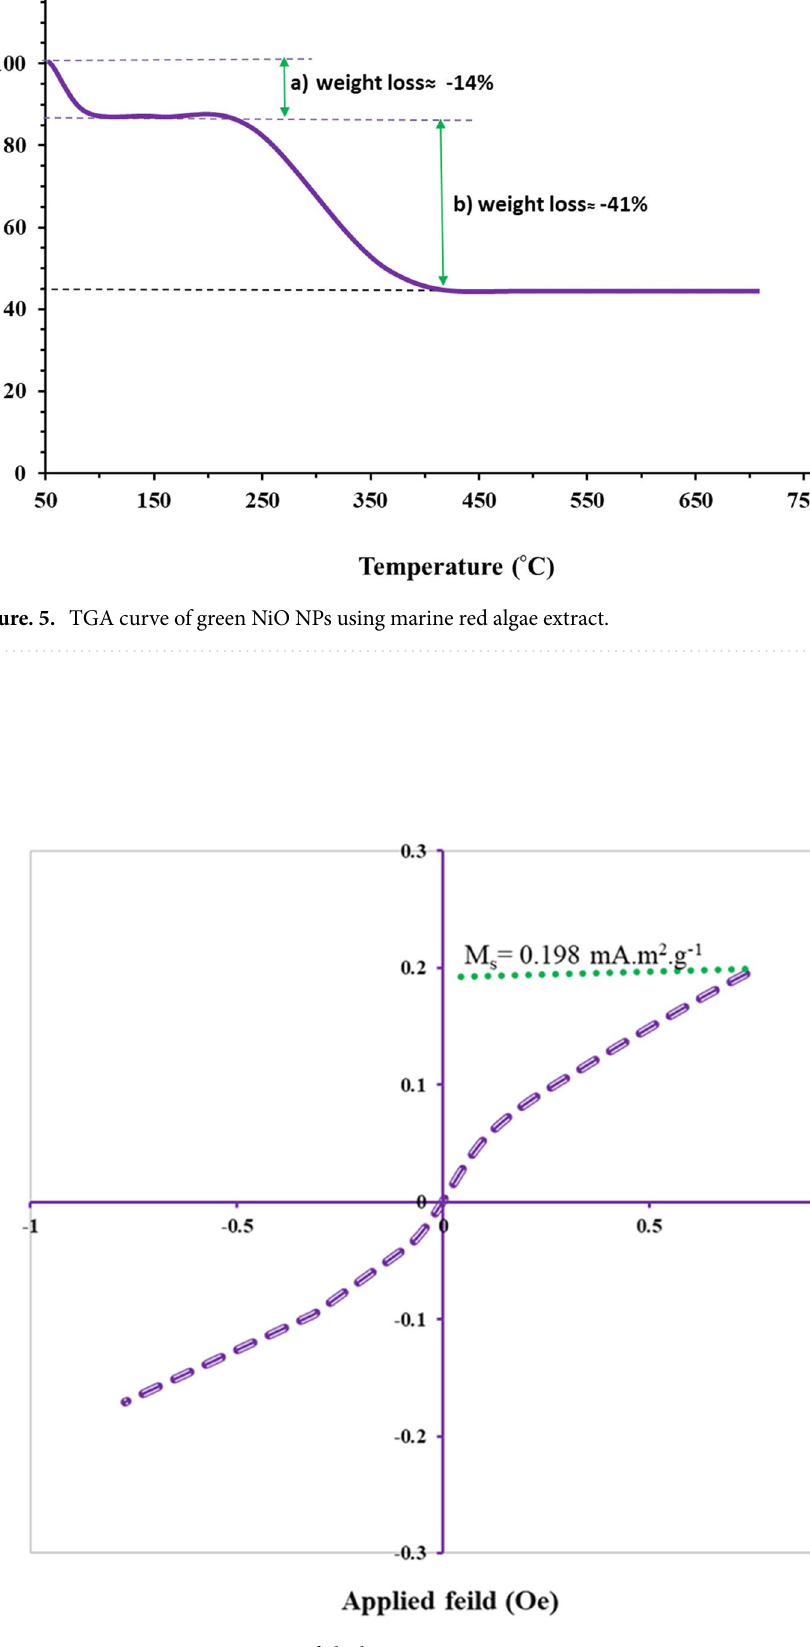
Figure 6. VSM magnetization curve of algal NiO